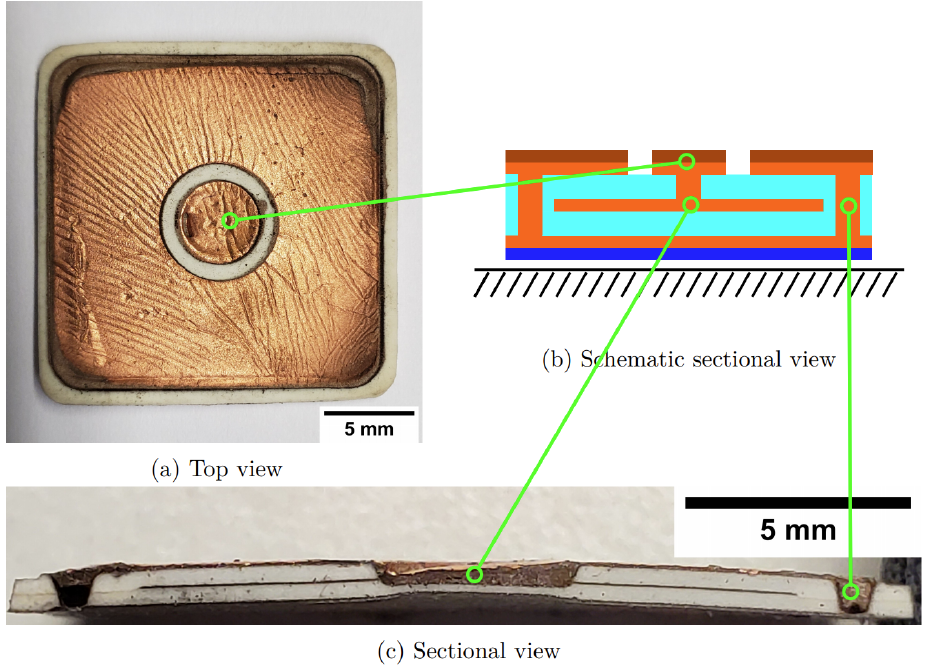
Figure 8. Top view ( a ), schematic cross-sectional view ( b ) and cross-sectional view ( c ) of a manufac- tured pressure sensor. The insulation ring between the inner and outer electrode is not visible in the cross-sectional view due to the electrode material behind